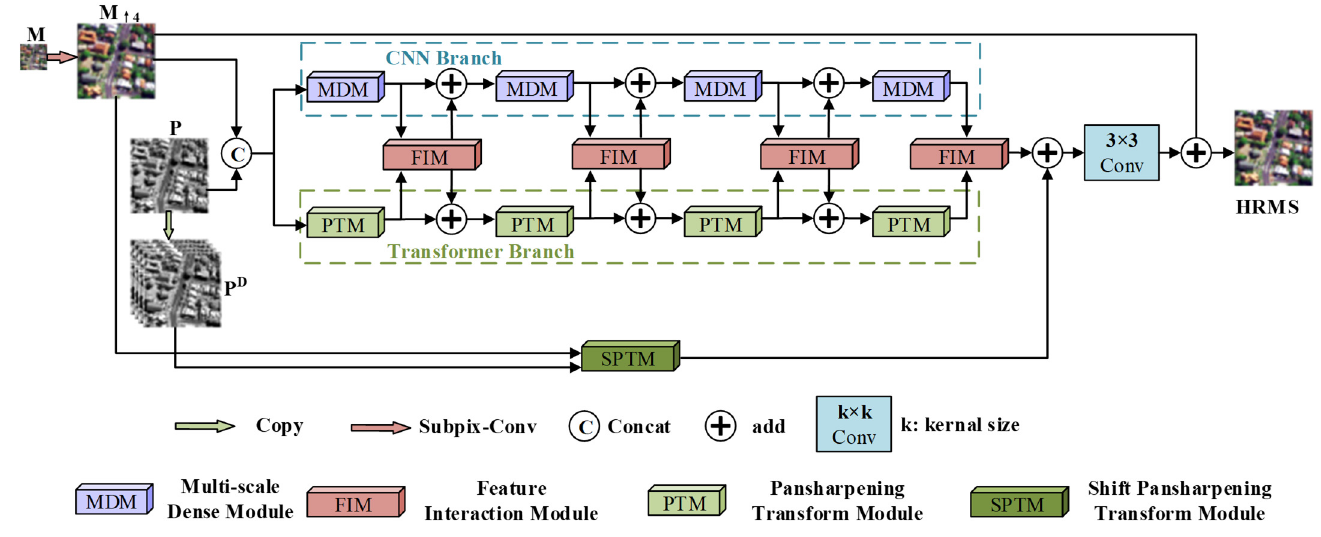
Figure 1. The framework of the LNFIN.